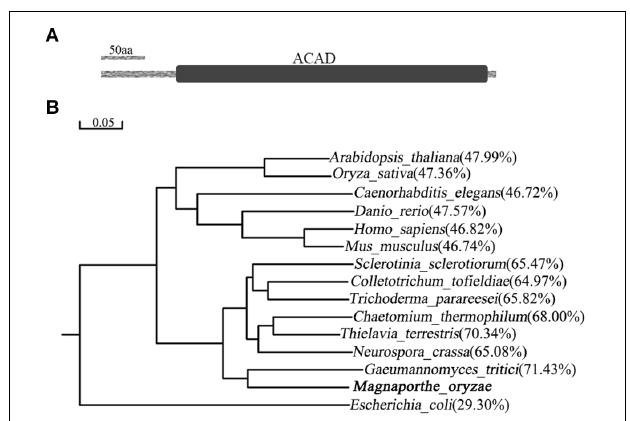
FIGURE 1 | Domain structure of MoIvd and phylogenetic analysis of IVD homologs. (A) MoIvd domain prediction by the PFAM website (http://pfam.xfam.org/). The ACAD domain located between aa91 and aa464. The bar indicates 50 amino acids. (B) IVD phylogenetic tree constructed using the observed divergency method by DNAMAN6.0. The IVD protein sequences of 15 model species were collected from NCBI database. The bar indicates 0.05 distance units. The percentage in brackets indicates sequence identity between MoIvd and corresponding homolog. The sequence accession numbers are listed as follows: Magnaporthe oryzae (XP_003721261.1), Arabidopsis thaliana (NP_190116.1), Oryza sativa (XP_015639342.1), Caenorhabditis elegans (NP_500720.1), Danio rerio (NP_958899.1), Homo sapiens (NP_002216.2), Mus musculus (NP_062800.1), Sclerotinia sclerotiorum (APA11203.1), Colletotrichum tofieldiae (KZL76390.1), Trichoderma parareesei (OTA08745.1), Chaetomium thermophilum (XP_006691847.1), Thielavia terrestris (XP_003651516.1), Neurospora crassa (XP_964284.1), Gaeumannomyces tritici (XP_009227932.1) and Escherichia coli